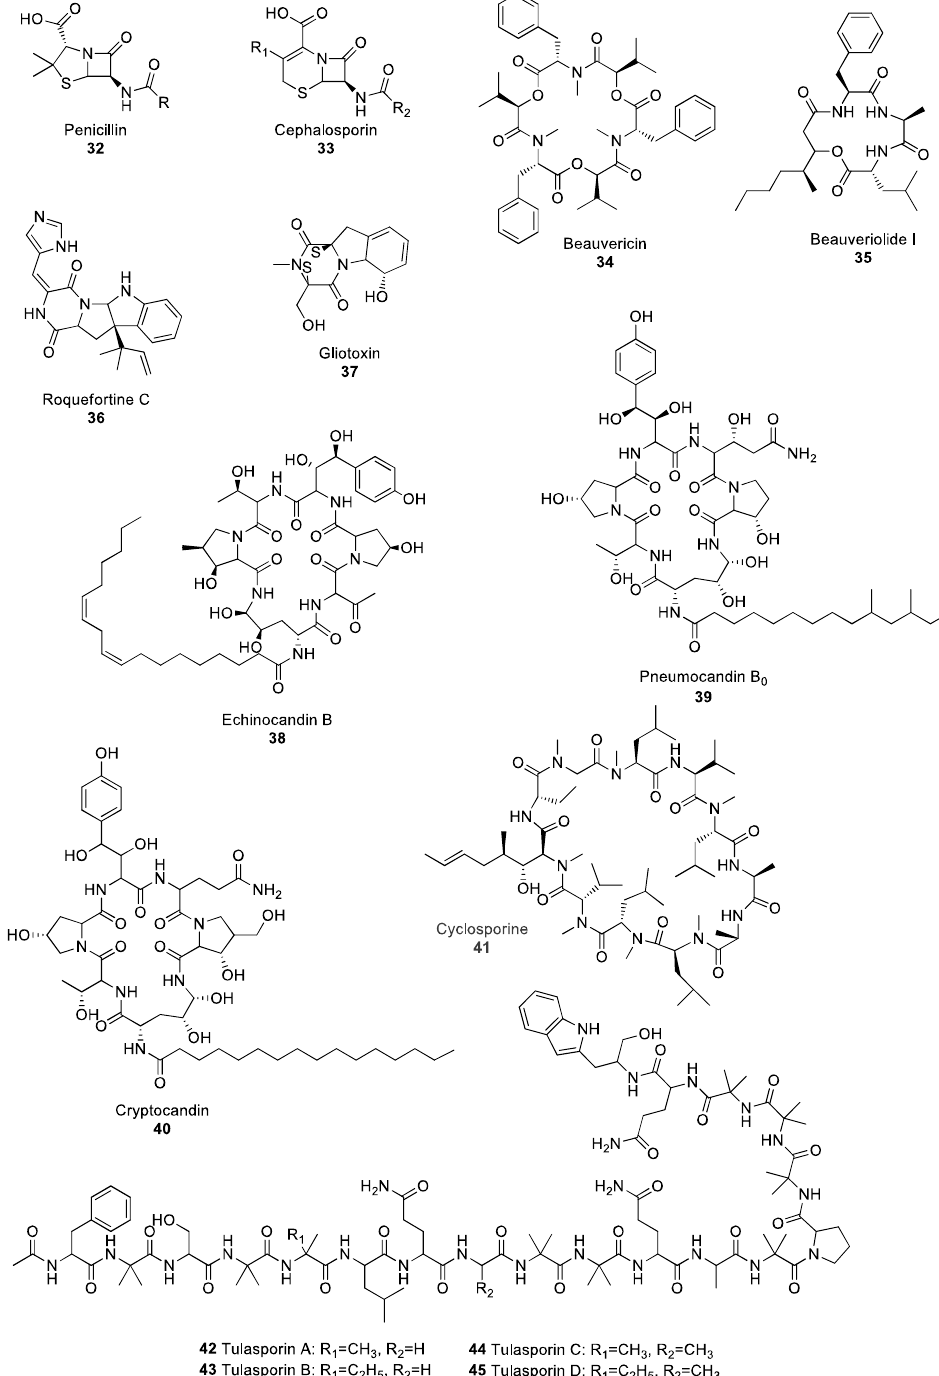
Figure 4. Diverse structures of selected non-ribosomal peptide (NRP)-derived fungal natural products.